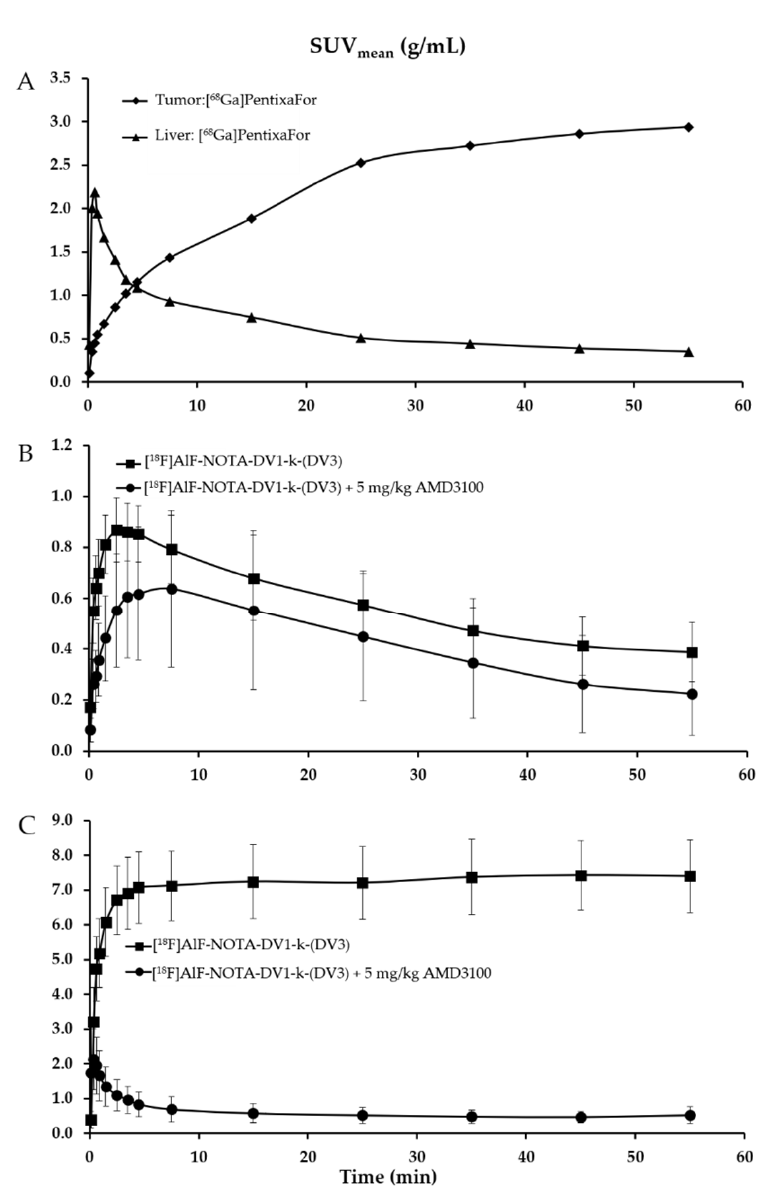
Figure 4. PET/CT imaging in U87.hCXCR4 tumor-bearing mice. MIP image (50–60 min p.i.): ( A ) AMD3100.